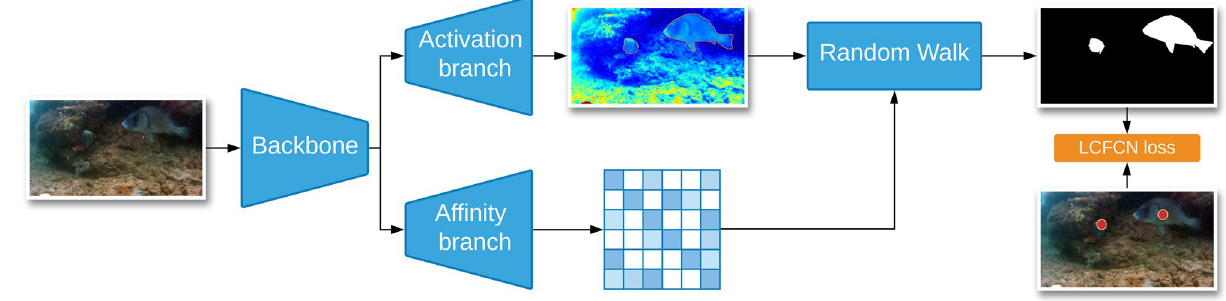
Figure 3. Affinity-based architecture. The first component is the ResNet-38 backbone which is used to extract features from the input image. The second component is the activation branch, which receives features from the backbone and outputs per-pixel scores with a 1 × 1 convolution. The third component is the affinity branch, which outputs an affinity matrix by upsampling backbone features at three different depths and merging them with a 1 × 1 convolution. These two outputs are aggregated using a random walk to get the final, refined per- pixel output. The images here were obtained from the open-source DeepFish dataset available at https:// alzay ats. github. io/ DeepF